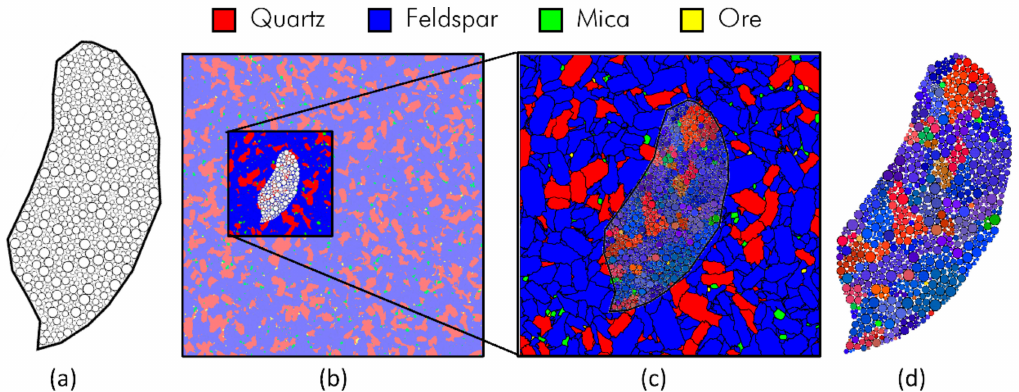
Figure 11. Procedure for mapping a microstructure onto a packing inside a polygonal particle in false-color mode: ( a ) Initial packing of discrete elements (0.1 to 0.5 mm) in the shape of a particle; ( b ) Random superimposition of the microstructure and the initial packing; ( c ) Actual mapping of the microstructural information onto the individual discrete elements of the packing; ( d ) Final particle with realistic shape and microstructure in YADE. For better demarcation, grains of the same material are painted in variations of the paired base